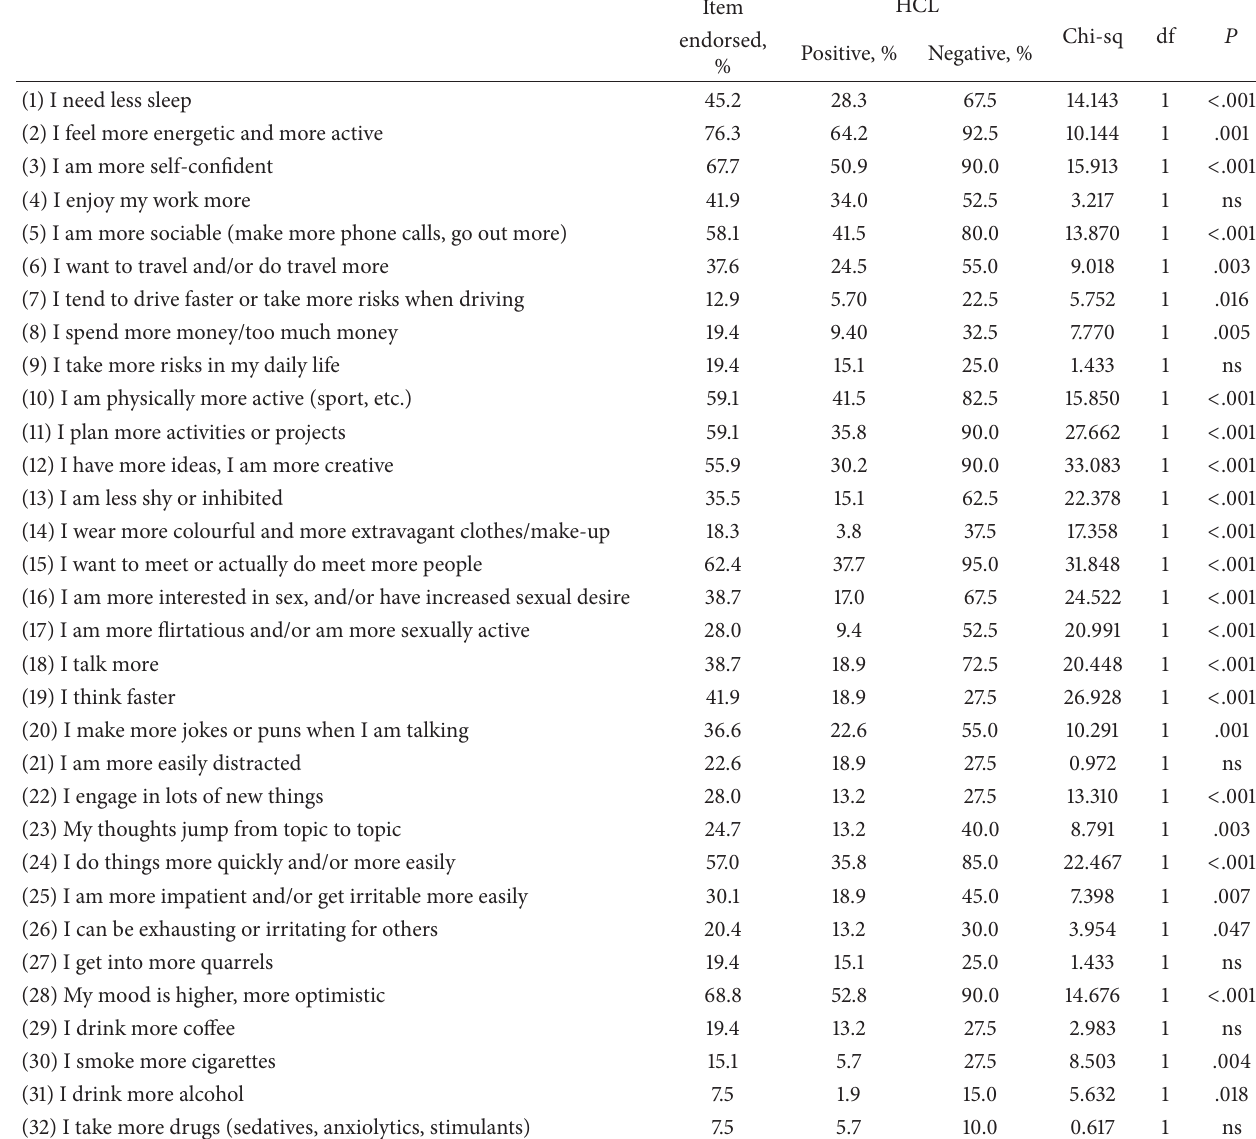
Table 4: Frequencies of endorsed items to HCL-32 (standard cut-off ∗ ) and correlation with positive screening.